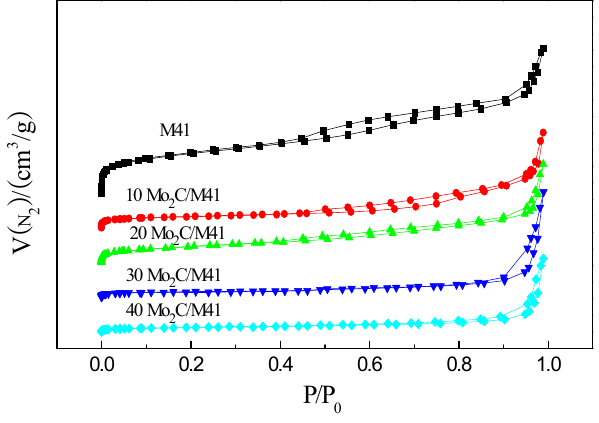
Figure 3. N 2 adsorption and desorption isotherms of the y Mo 2 C/M41 samples. Table 2. N 2 adsorption data of the y Mo 2 C/M41 samples. BET: Brunauer–Emmett–Teller. Samples